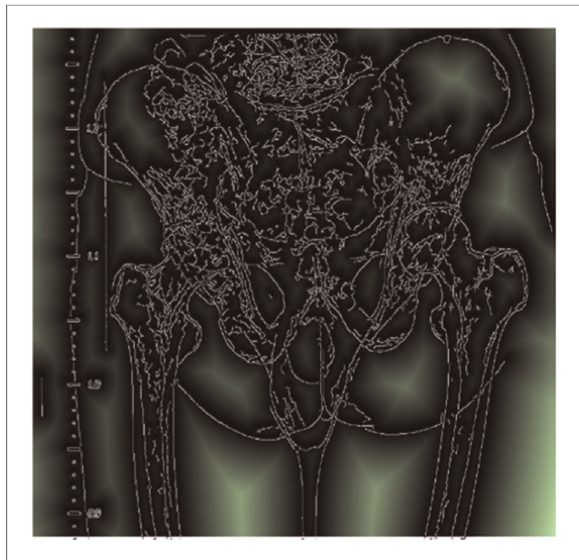
FIGURE 2 Bone edge registration, after edges were extracted using canny algorithm; and to determine the true bone edge, the bright areas are excluded as they are considered far from